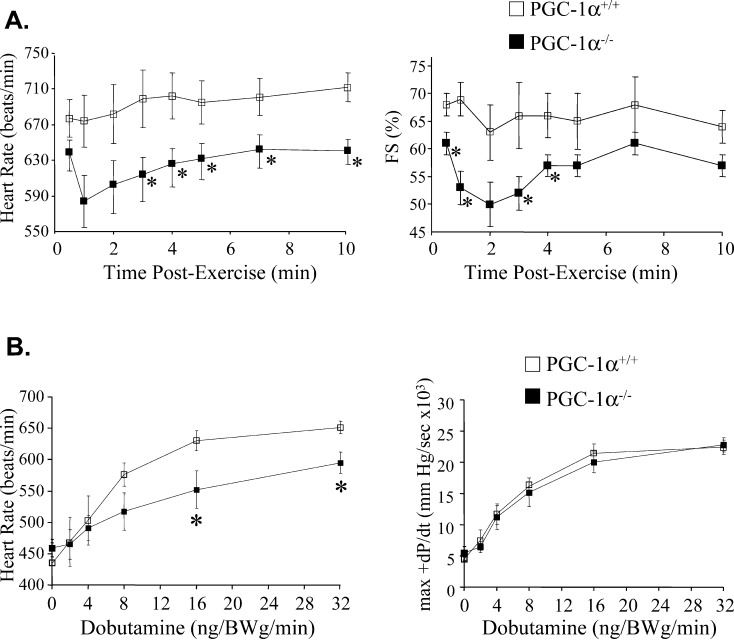
Abnormal Cardiac Response to Physiologic Stress in PGC-1α−/− Mice(A) Exercise echocardiographic studies. PGC-1α+/+ (n = 4) and PGC-1α−/− (n = 8) female mice aged 6–8 mo were subjected to an exercise protocol on a motorized treadmill. This protocol was designed such that the PGC-1α−/− mice ran to exhaustion based on the results of the exercise studies shown in Figure 4. Accordingly, an exercise regimen of 60 s was used for both groups. The graphs depict the heart rate (left graph) and echocardiographically-determined ventricular fractional shortening (FS) as a percent (right graph). Responses were monitored for 10 min immediately post exercise.(B) In vivo hemodynamic response to the β1,α1-adrenergic agonist dobutamine. Male and female PGC-1α+/+ (n = 6) and PGC-1α−/− (n = 6) mice at 10–12 wk of age were anesthetized and a 1.4-French Millar catheter was placed through the carotid artery into the left ventricle as described in Materials and Methods. Heart rate (left graph) and a measurement of ventricular systolic performance, dP/dt (right graph), were measured following infusion of dobutamine. * p < 0.05.